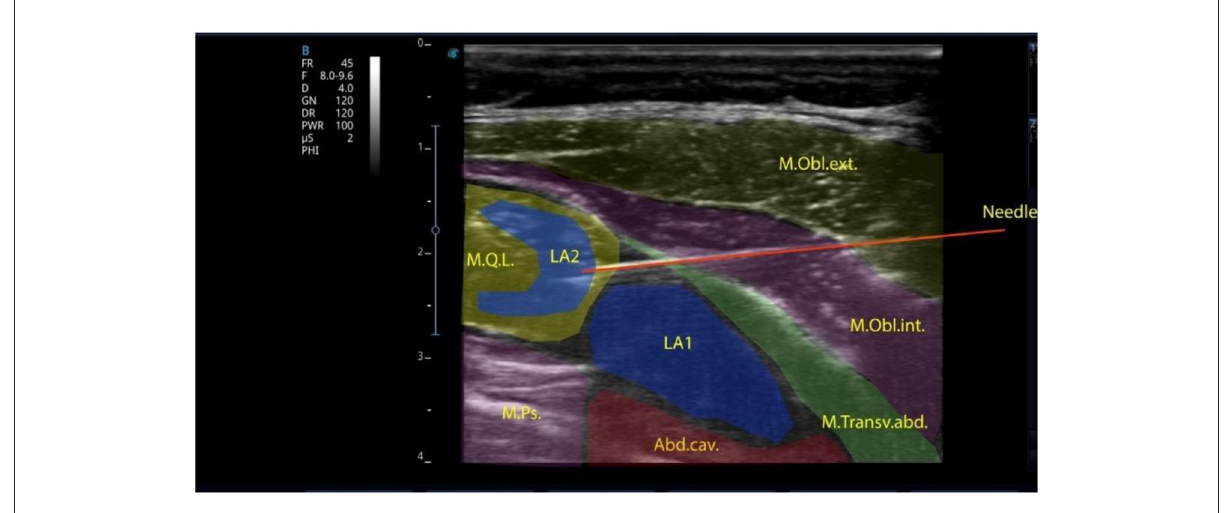
FIGURE1 Local anesthetic injected into the transversalis fascia plane in the lumbar region and the quadratus lumborum muscle